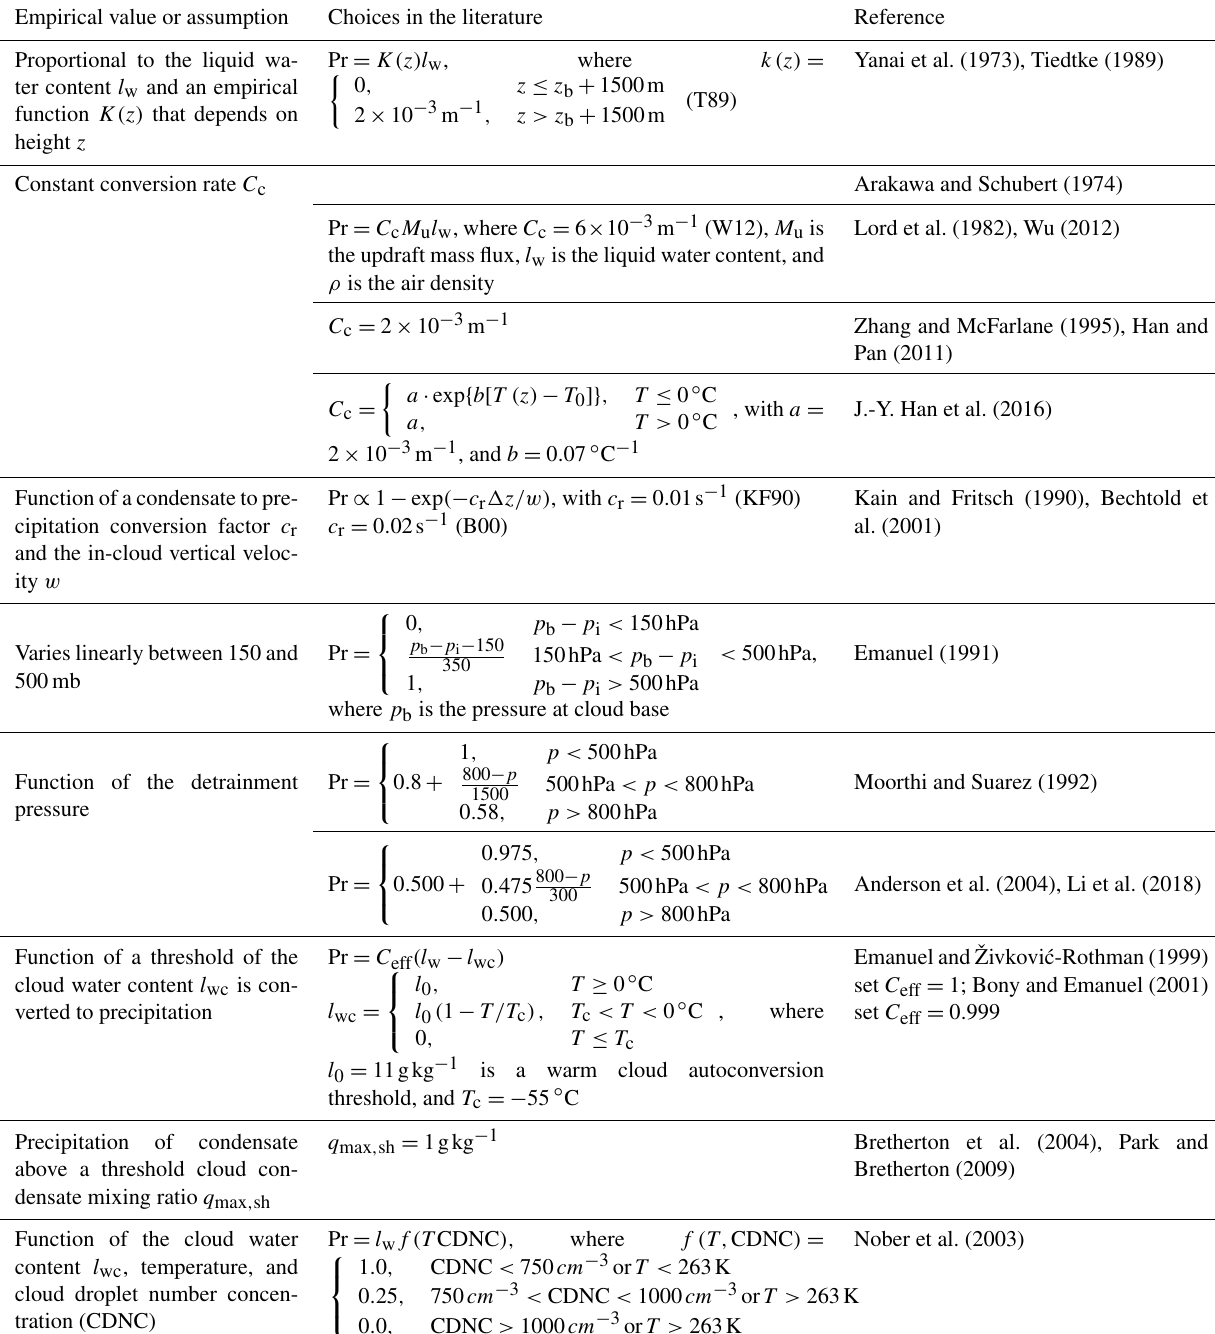
Table 10. A sample of empirical values and assumptions used in the conversion of cloud water to precipitation (note: subscript “sh” refers to shallow